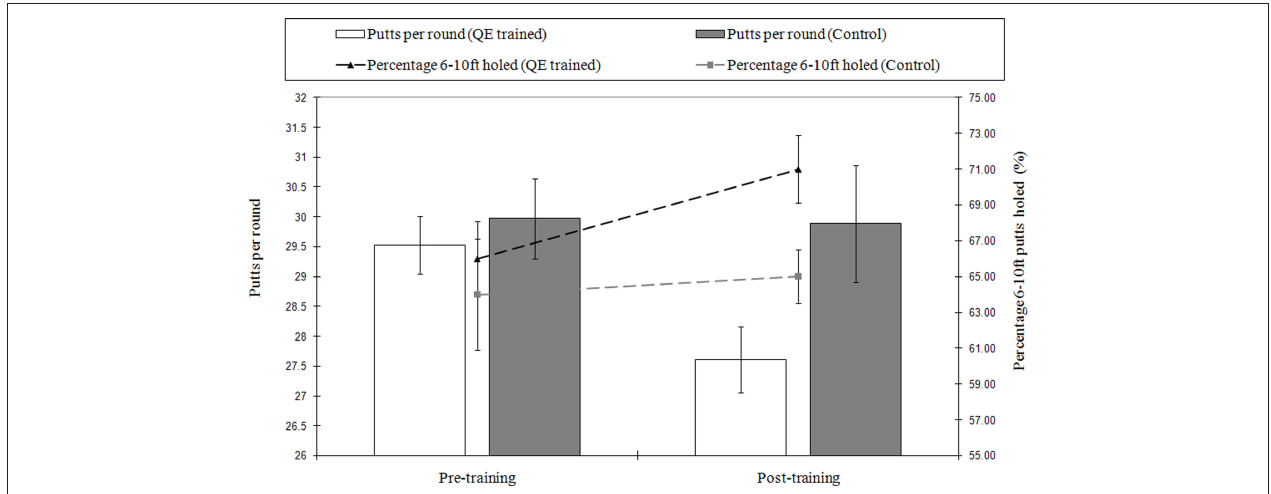
FiguRE 3 | Competitive performance: Number of putts per round and percentage 6–10 ft putts holed (%) for QE-trained and Control groups during pre-training and post-training rounds ( ±